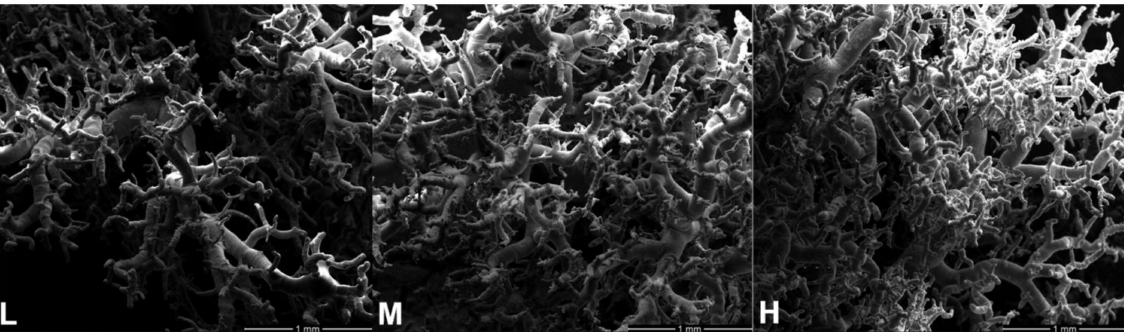
Figure 5. Branching characteristics of pulmonary arteries at low (L), middle (M), and high (H) altitudes under 100 × field of view.